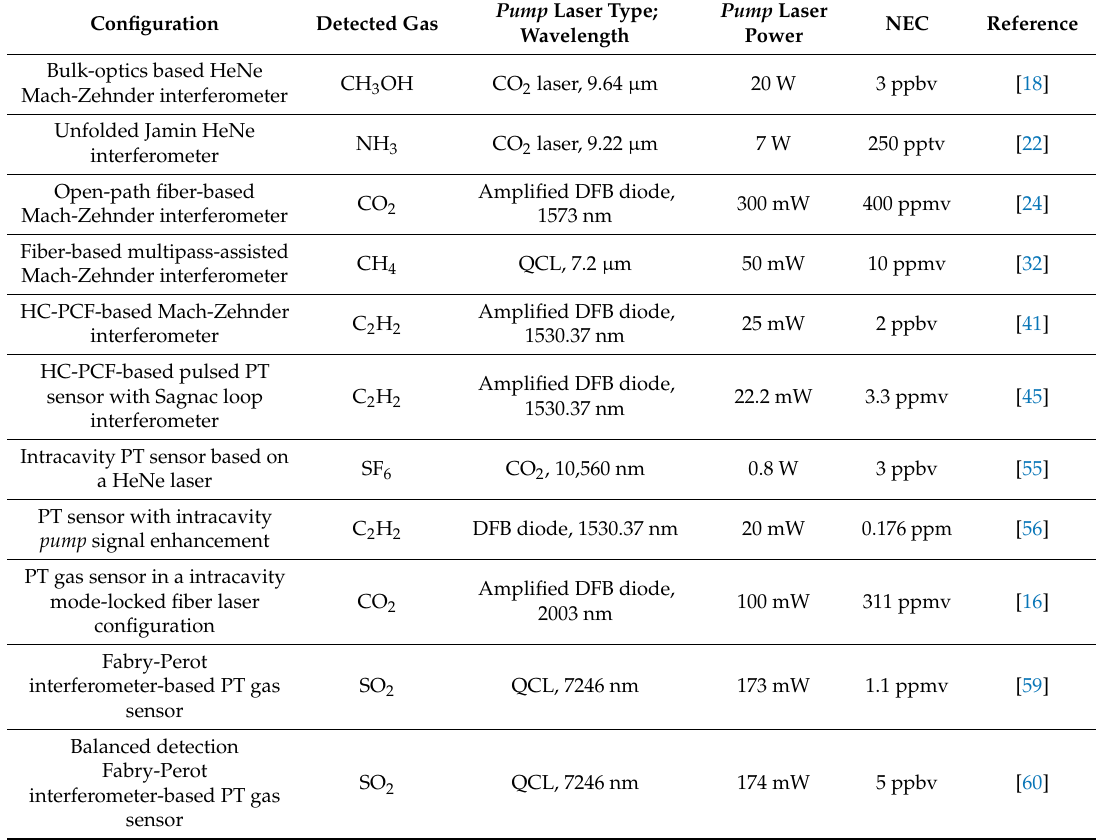
Table 1. Summarized sensitivities of PT gas sensors described in this